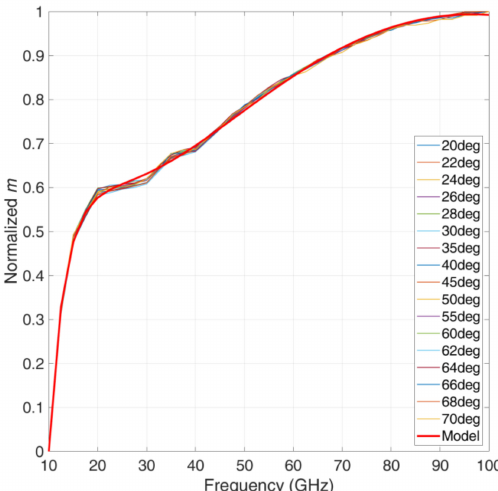
Figure 1. Normalized value of the average exponent of the global SST, between 10 GHz and 100 GHz. The thin lines give the average value for each elevation angle. The thick red line gives the model m n ( f ) . Notice that the normalized value of each elevation angle is practically the same, regardless of frequency and locality, a fundamental result that allows the modelling reported in step (3) of range (b). The superposition of the thin colored lines indicates that the global SST model can be applied to every site.